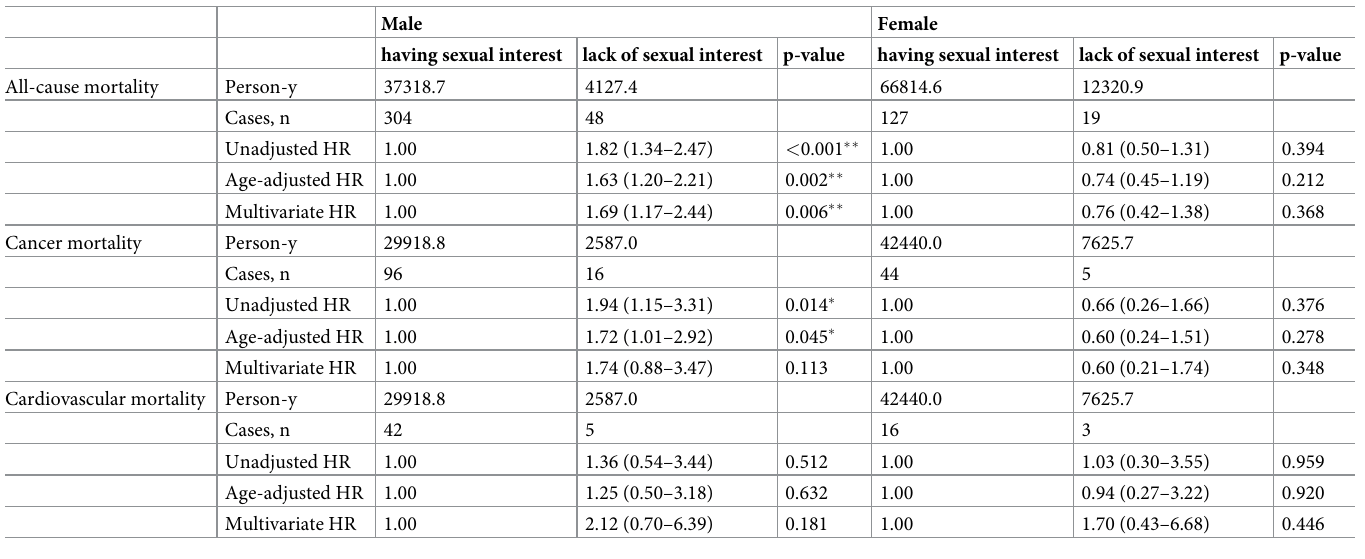
Table 2. Sex-specific unadjusted, age-, and multivariable-adjusted HRs and 95% CIs of mortality according to lack of sexual interest. Male Female having sexual interest lack of sexual interest p-value having sexual interest lack of sexual interest